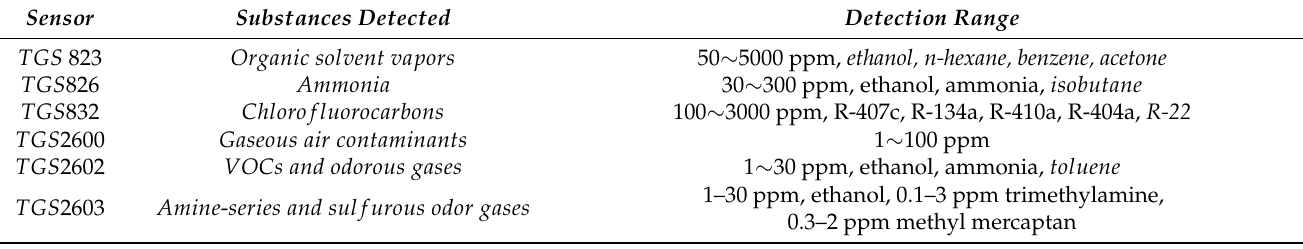
Table 1. The characteristics of semiconductor gas sensors, which were used in the multi-sensor array ([9], https://www. figaro.co.jp/en (accessed on 17 July 2021)).